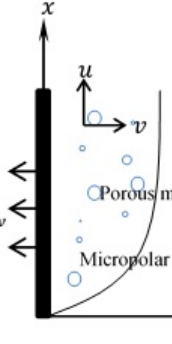
Figure 1. Configuration of the flow.